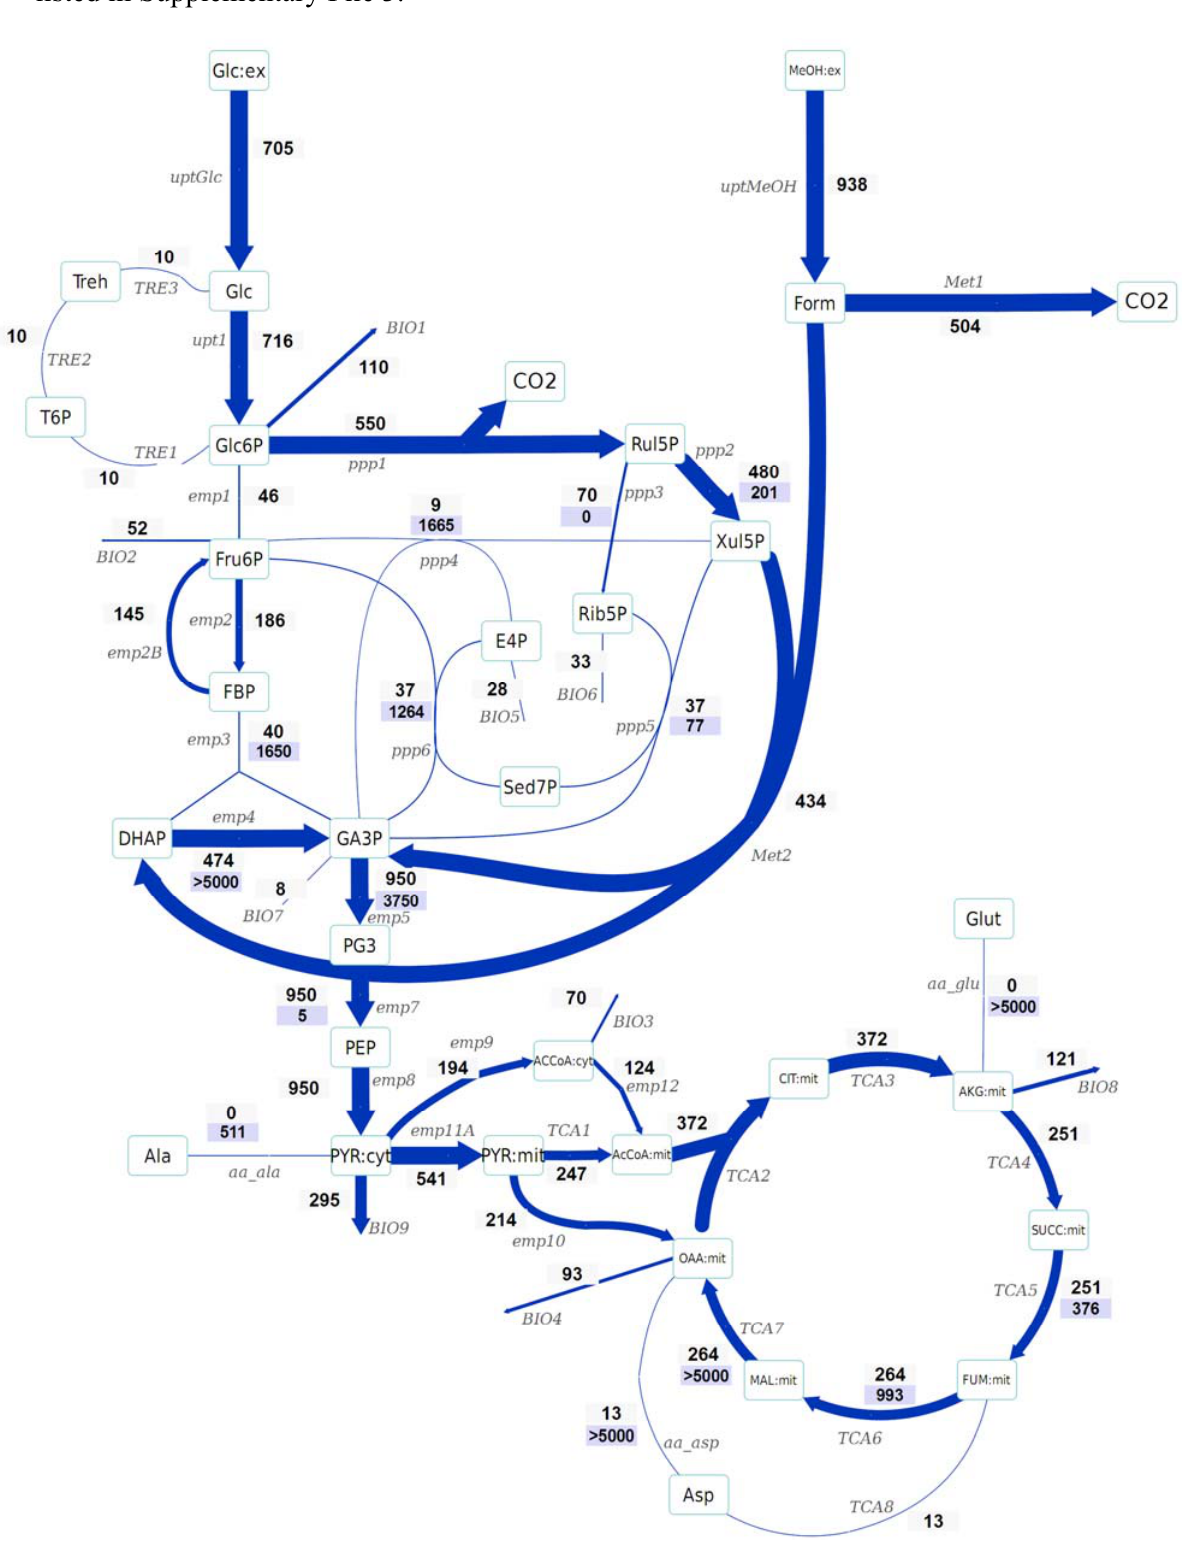
Figure 2. Metabolic flux distributions of the control strain based on INST- 13 C-MFA. The /h. The width of the arrow represents the flux value. flux values are given in  mol/g DCW The upper values represent the net flux (in direction of the arrow), whereas the lower values (on blue background) reflect the backward flux (absolute). All the fluxes are also listed in Supplementary File